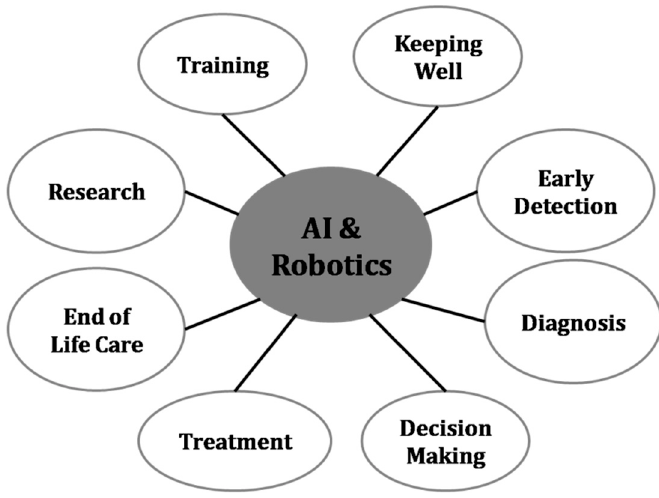
Figure 1. AI and Robotics for healthcare .